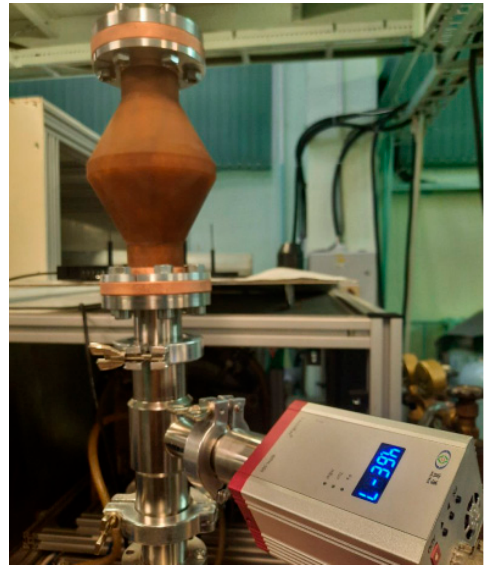
Figure 4. Vacuum testing of a test piece with an internal copper coating thickness of about 200 μ m and an internal volume of about 1 L.